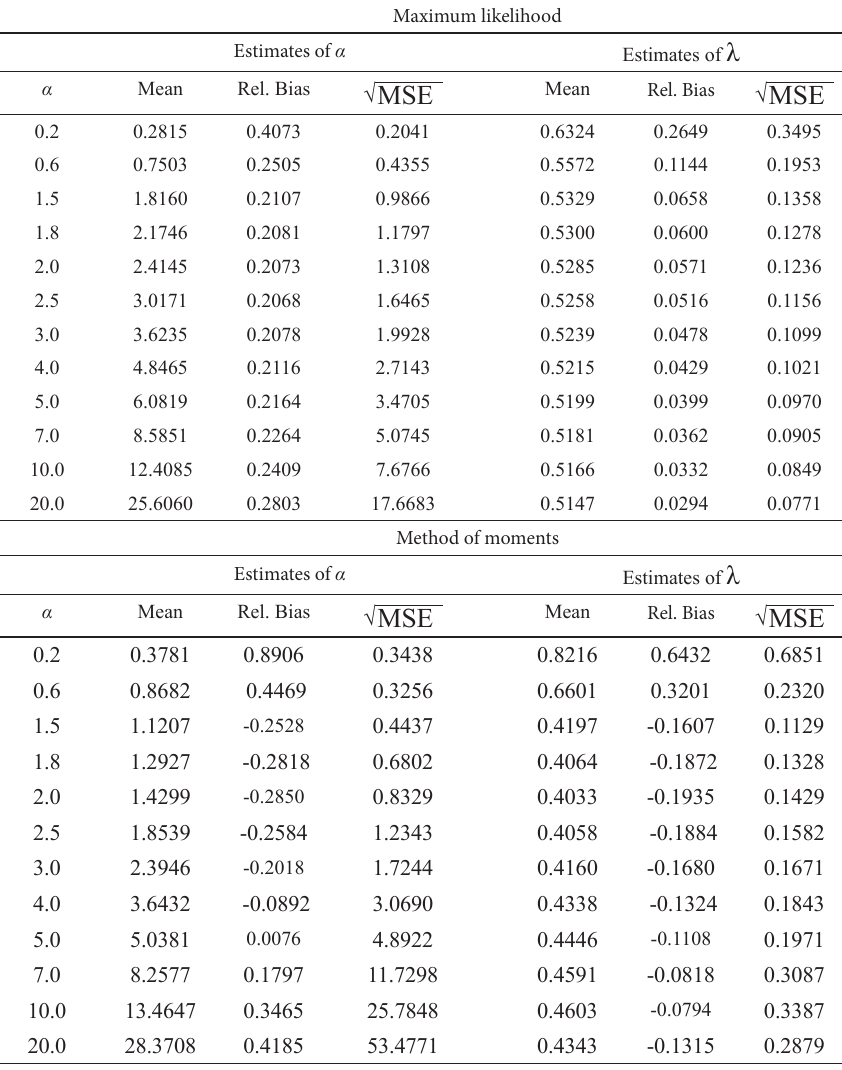
Point estimates for n =50 and different values of